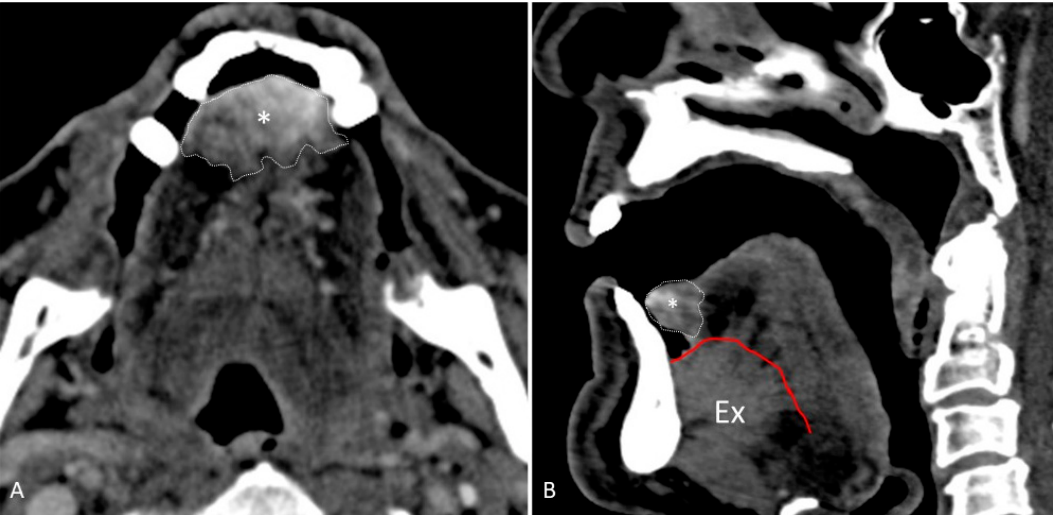
Figure 13. Open mouth MSCT technique. ( A ) Axial MSCT image of a squamous cell carcinoma of the lingual apex (*, outlined by the dotted line). This technique allows to separate the palatal mucosa from the muscular component of the tongue clarifying the exact origin, infiltration, and thickness of the lesion. ( B ) Sagittal MSCT image of the same patient. No infiltration of the extrinsic musculature of the tongue is observed (Ex, below the red line).